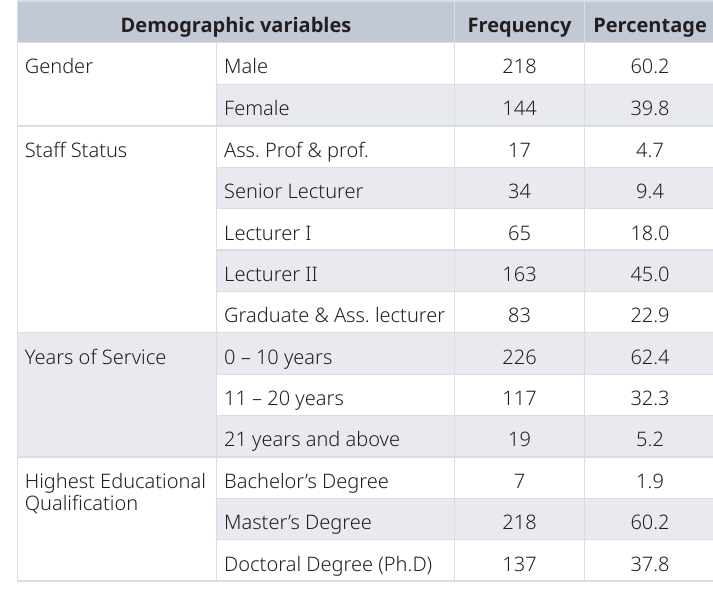
Table 3. Demographic characteristics of the academic staff.